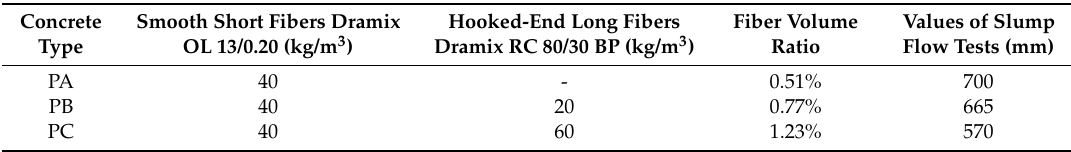
Table 1. Steel fiber contents and results of slump flow tests. Concrete with deflection-softening behavior (Concrete PA); concrete with mild deflection-hardening behavior (Concrete PB); concrete with marked deflection-hardening behavior (Concrete PC).